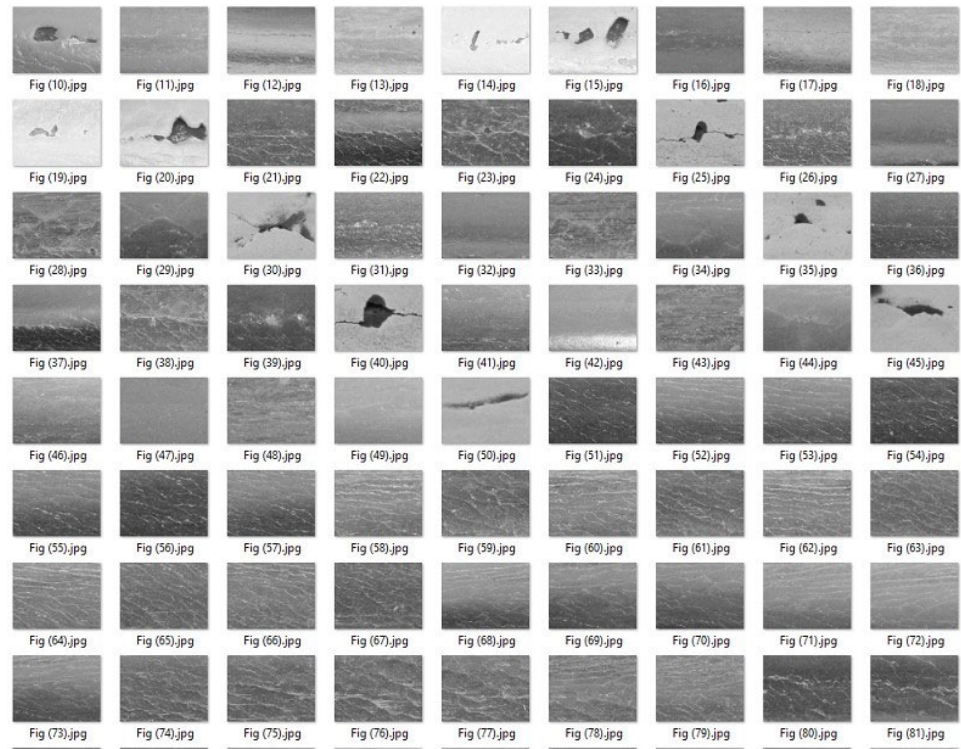
Figure 5. Images under different lighting conditions.